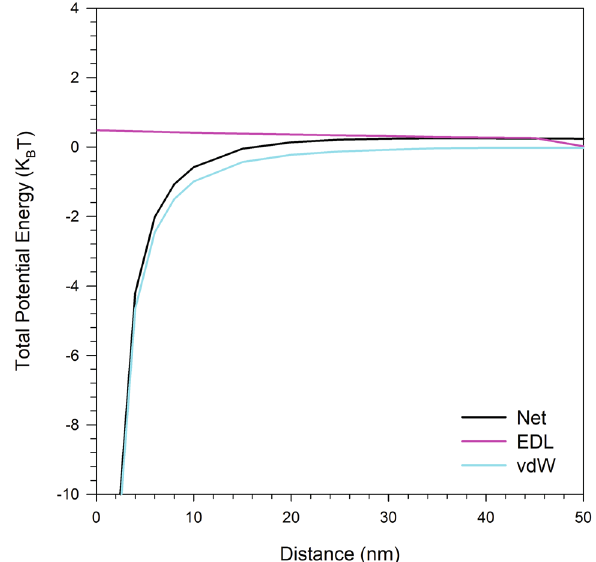
Fig. 9 Total potential energy versus inter-particle distance accord- ing to DLVO theory, showing the influence of neutral (pH 7) diH for QDs suspended in aqueous solution. Calculation of DLVO theory includes the contributions of the van der Waals and electric double layer (EDL) interactions. The net energy (Net) shown is the sum of EDL repulsion and van der Waals attraction between two approach- ing